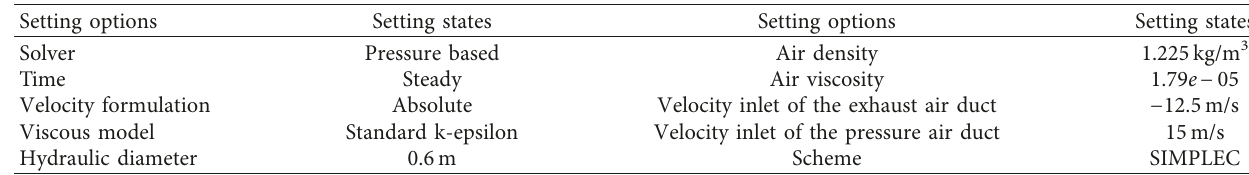
Table 1: Parameter settling of the continuous phase model.